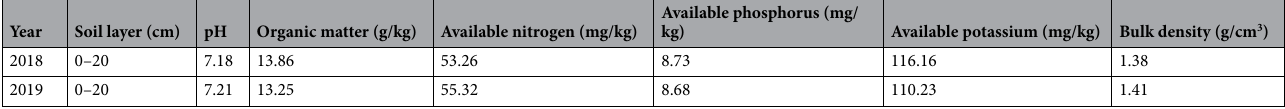
Table 1. Physical and chemical properties of the experimental field soil.